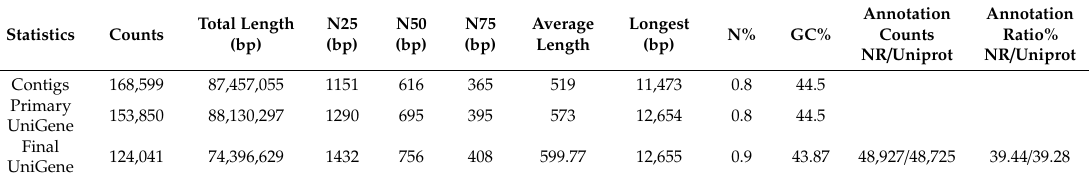
Table 2. Summary for the Oriental hybrid lily ‘Sorbonne’ transcriptome.